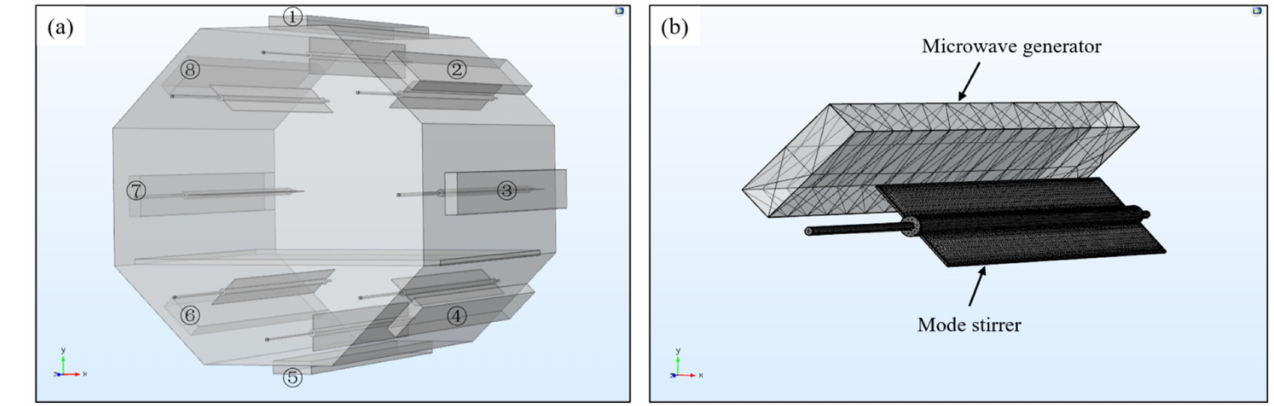
Figure 3. ( a ) Geometric model of the microwave cavity; ( b ) mesh generation of the microwave generator and the mode